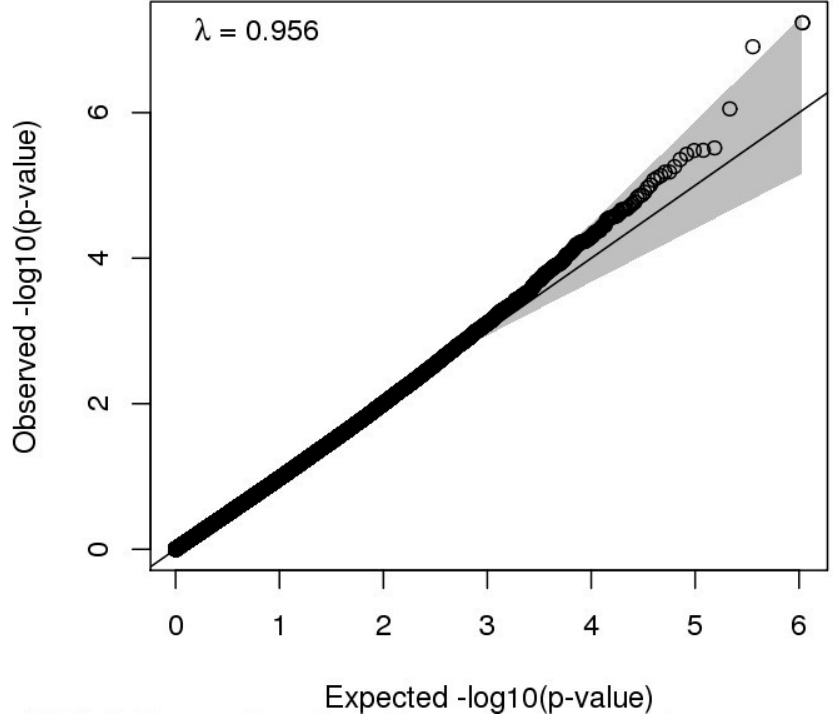
Figure 2. Quantile–Quantile (QQ) plot of the Epigenome-Wide Association Study (EWAS) for breastfeeding duration >6 months and DNAm in IOWBC at 10 years.